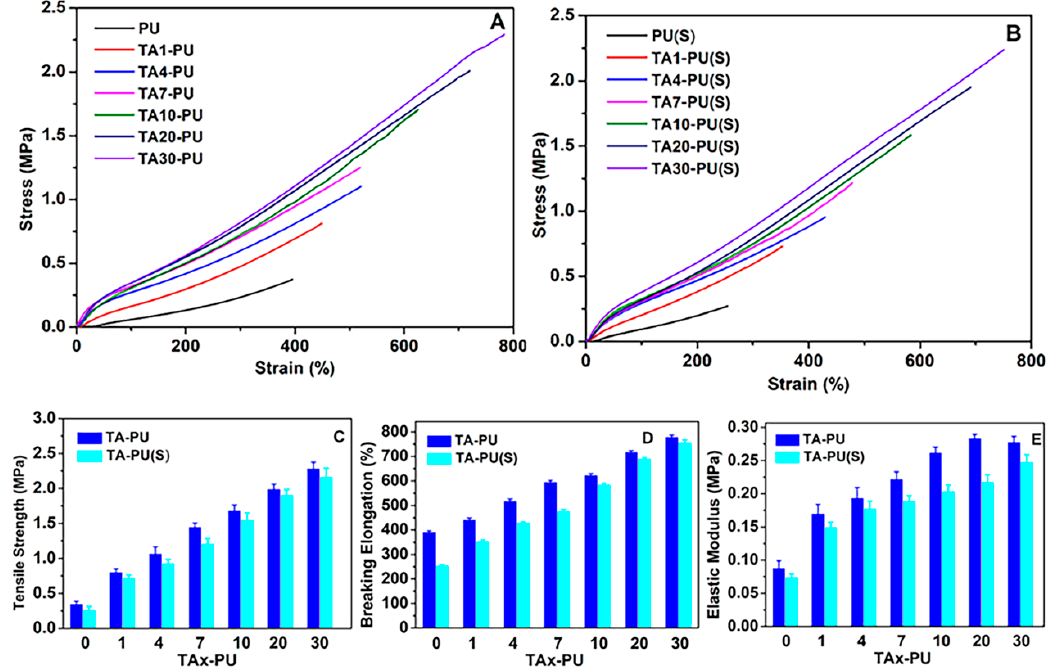
Figure 4. Tensile strain–stress curves of TA–PU hydrogels at as-prepared ( A ) and swelling equilibrium ( B ) states. Mechanical properties of pure PU and TA–PU hydrogels: ( C ) tensile strength; ( S ) breaking strain; ( E ) elastic modulus.